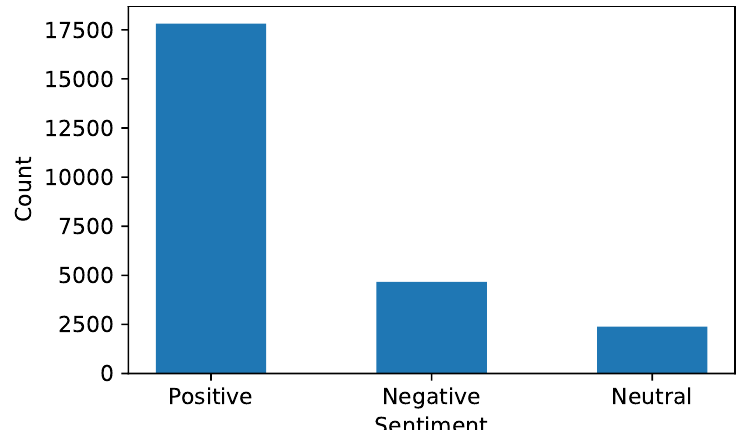
Figure 2. Sentiment count for the dataset reviews.